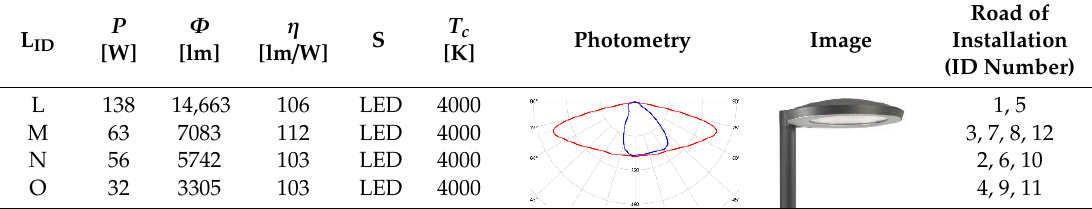
Table 9. Photometric data of the luminaires at the design status. The following symbols are used; L ID : luminaires identification letter; P : luminaire power; Φ : luminaire luminous flux; η : luminaire efficacy; S: source type; T c : correlated colour temperature; LED: light-emitting Diode.